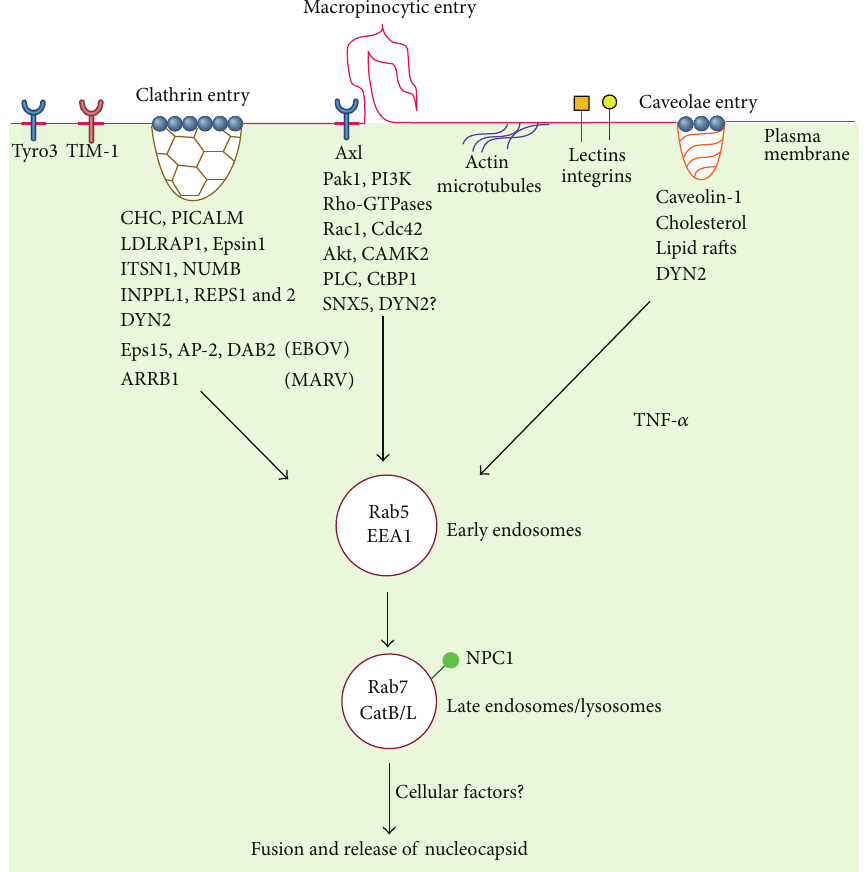
F 1: Schematic representation of cellular endocytic pathways and factors implicated in �lovirus